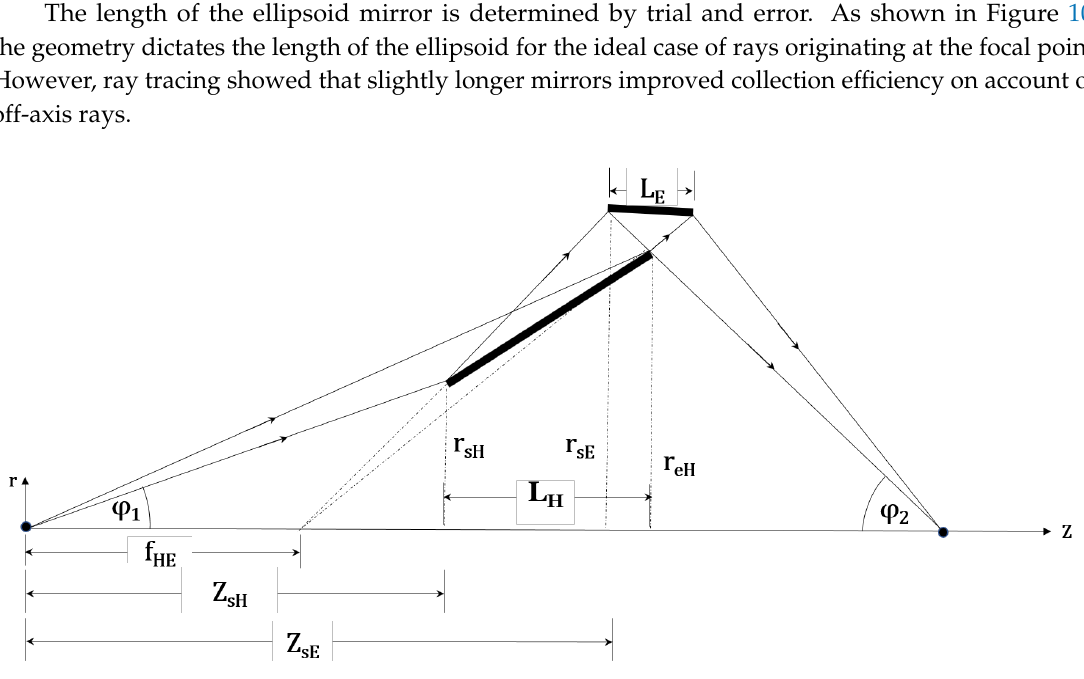
Figure 10. Geometry of the Wolter III optics. Rays from the optical axis are shown for demonstration. Z sH is the working